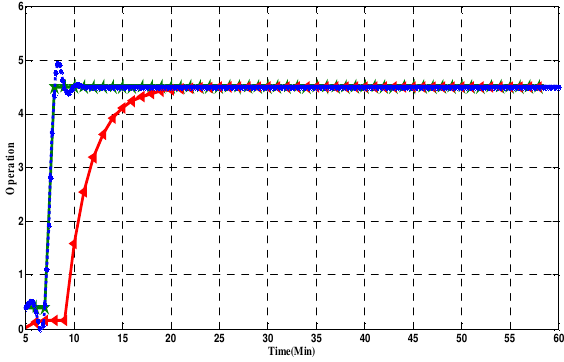
Fig. 6. Increasing the speed of response for operation.